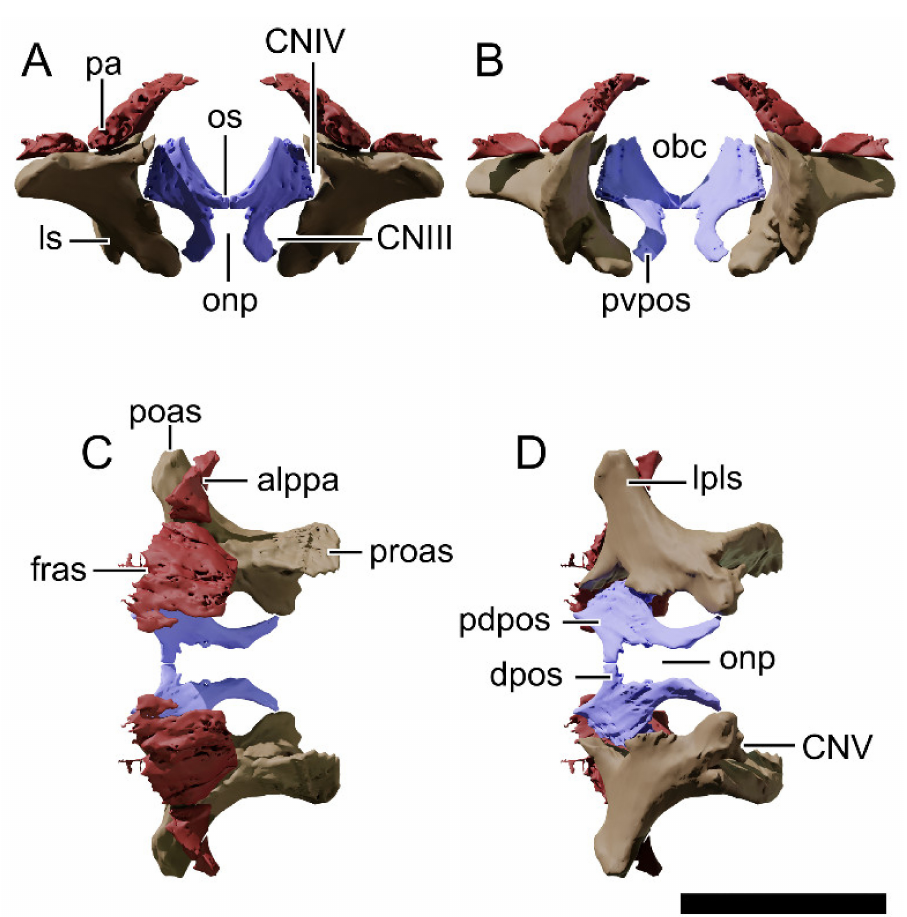
Figure 22. Digital reconstruction of the left upper braincase elements of NHMD 164758. ( A ) Anterior view. ( B ) Posterior view. ( C ) Dorsal view. ( D ) Ventral view. The elements were articulated and mirrored digitally for the reconstruction. Abbreviations: alppa, anterolateral process of the parietal; CN, cranial nerve; dpos, dorsal process of the orbitosphenoid; fras, articular surface for the frontal; lpls, lateral process of the laterosphenoid; ls, laterosphenoid; obc, olfactory bulb canal; onp, optic nerve passage; os, orbitosphenoid; pa, parietal; pdpos, posterodorsal process of the orbitosphenoid; poas, articular surface for the postorbital; proas, articular surface for the prootic; pvpos, posteroventral process of the orbitosphenoid. Scale bar = 20